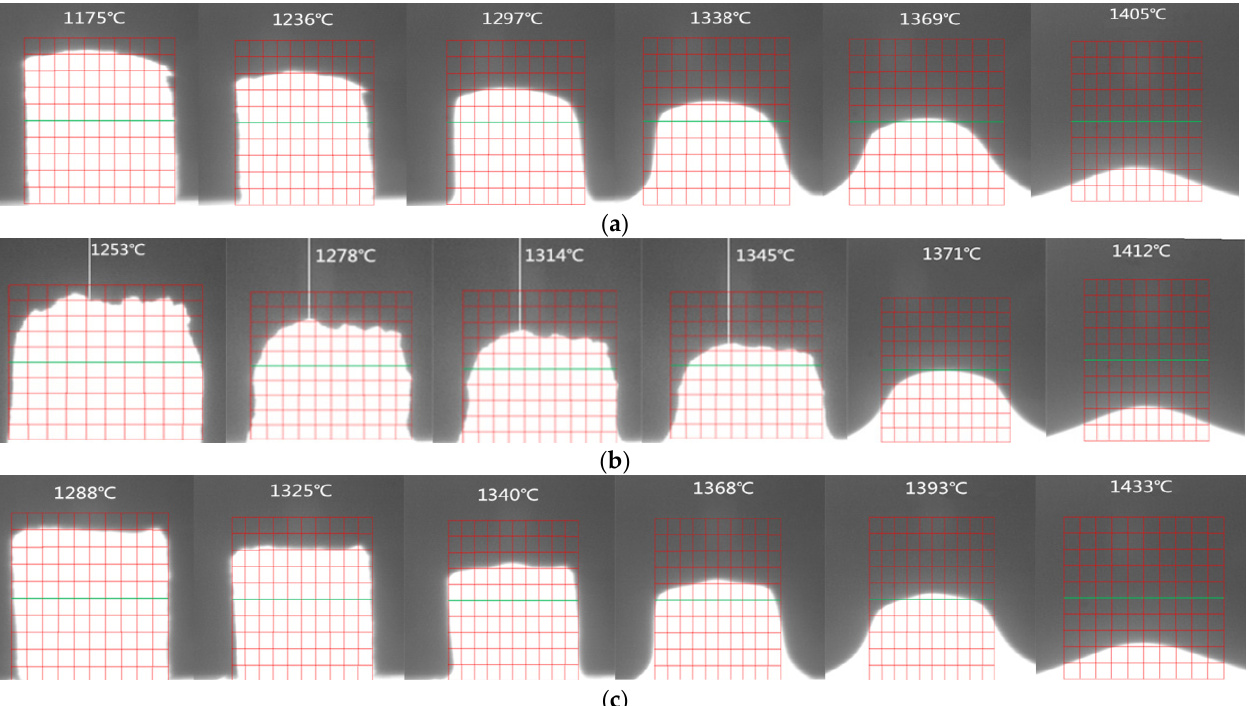
Figure 8. Melting process for samples with different MgO contents. ( a ) MgO content of 1.0%; ( b ) MgO content of 2.0%; ( c ) MgO content of 3.0%.